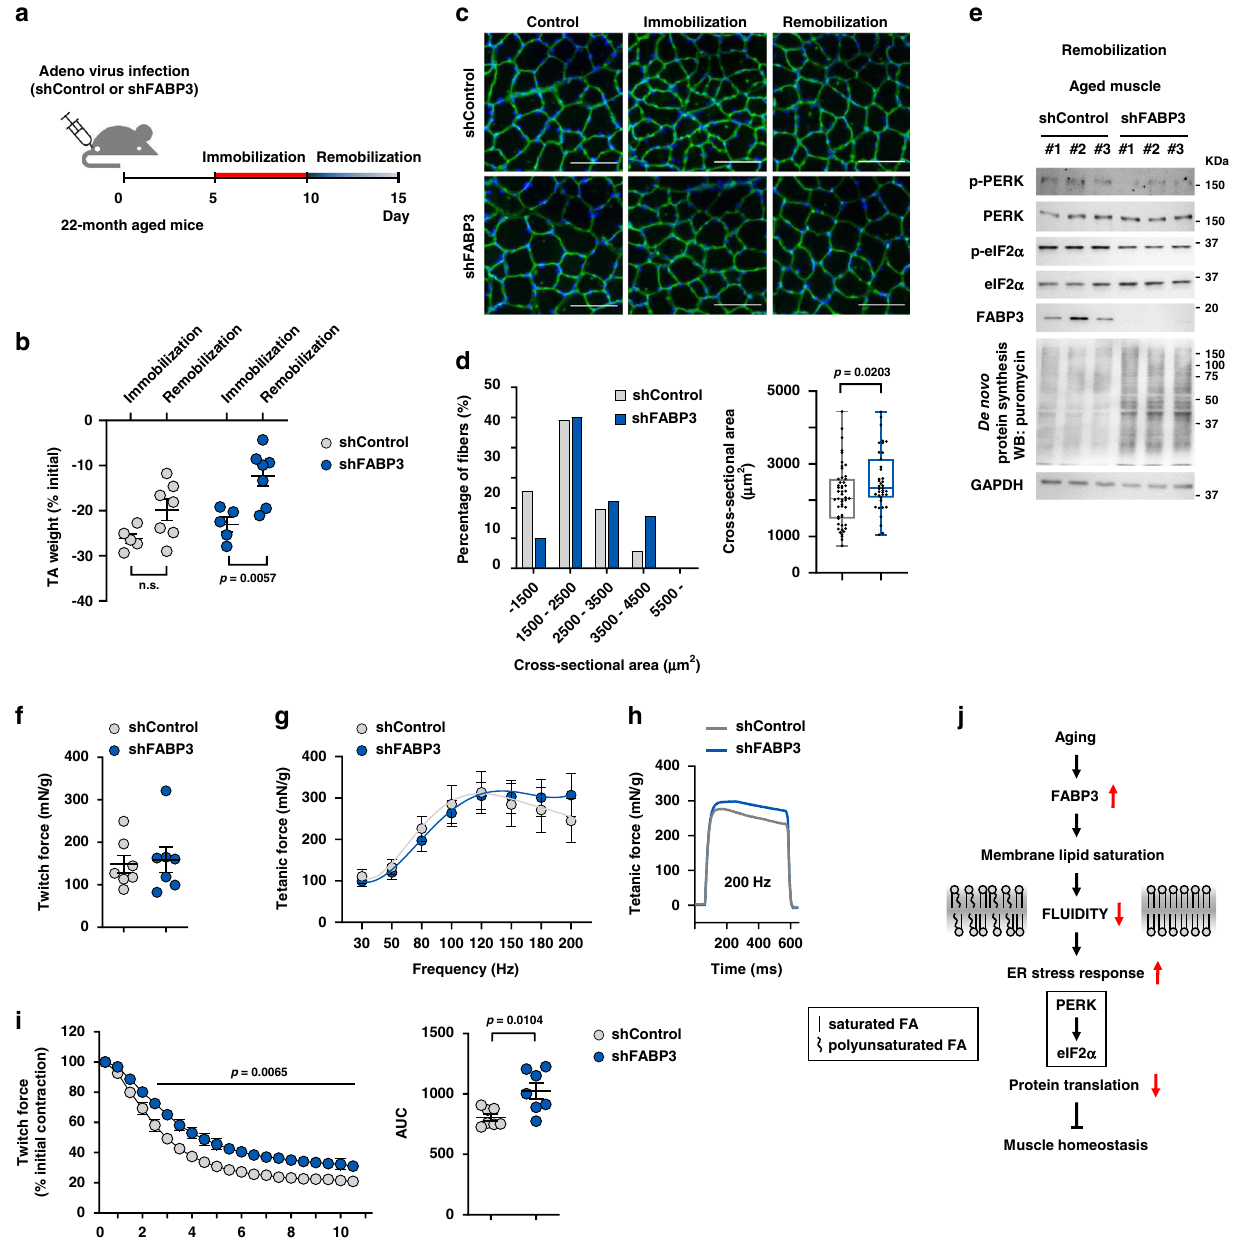
Fig. 8 FABP3 knockdown ameliorated an impaired muscle recovery in aged mice. a Scheme of the experimental procedures. TA muscles of aged mice were infected with Ad-shFABP3 or Ad-shControl virus, immobilized with a surgical staple 5 days after infection, and allowed to recover (remobilization) after 5-day immobilization. b TA muscle mass was measured at 5 days after immobilization ( n = 5) and 5 days after remobilization ( n = 7). Changes in muscle weight for immobilization and remobilization were expressed as the percentage of the contralateral non-immobilized muscle weight. c Representative images of laminin (red) and DAPI (blue) staining of myo fi bers infected with Ad-shFABP3 or Ad-shControl virus Scale bar, 200 μ m. d Frequency histograms of the cross-sectional area (left) of Ad-shFABP3 or Ad-shControl virus-infected fi bers 5 days after remobilization. Box plot representing the mean fi ber cross-sectional areas (right). Box represent the 25th – 75th percentiles of the data; whiskers show the min and max range of the data; horizontal lines indicate the median value. e Immunoblot analysis of PERK and eIF2 α phosphorylation, and puromycin incorporation in Ad-shFABP3 or Ad-shControl virus-infected TA muscles after remobilization. TA muscles were harvested 30min post-interperitoneal puromycin injection. ( n = 3 mice per group). f – i Ad-shFABP3 or Ad-shControl virus-infected TA muscles were mounted on a force transducer. The maximum twitch force ( f ) at supra-maximal voltage, 100V for 1ms. Frequency dependence of average tetanic force curves ( g ) at 30 – 200Hz, 100V, 500ms for each frequency. Tetanic force traces ( h ) upon stimulation at 200Hz for 500ms. Data are presented as means. ( n = 7 mice per group) Fatigue index ( i ) was measured at 1Hz and 100V by repeated stimuli for 10min. Generated force was analyzed as a percentage of the initial contractile force ( n = 7 mice per group) (left). Insert represents area under curve (AUC) (right). Data are presented as means ± S.E.M. Two way ANOVA with Bonferroni ’ s post hoc test was used (left in i ) and two-tailed unpaired Student ’ s t -test was used ( b , d , right in i ). j Proposed model for age-dependent lipid remodeling by FABP3. Source data are provided as a Source Data fi